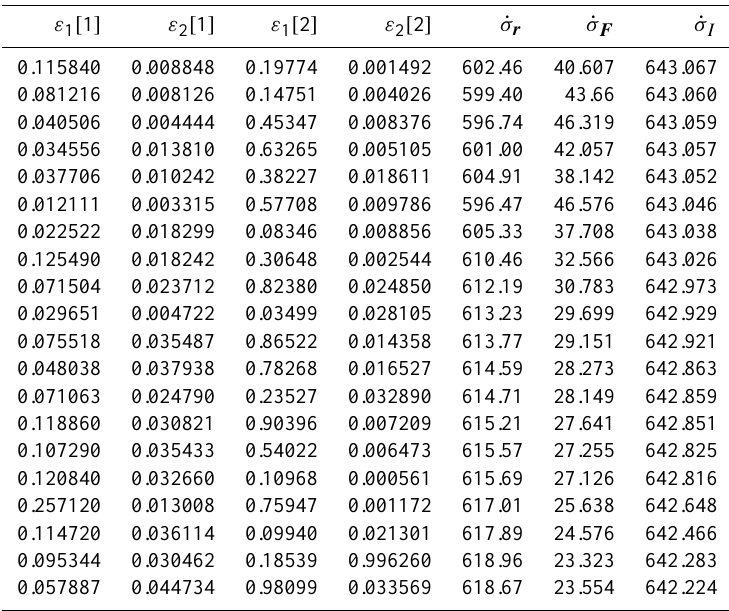
Table 3. Values in 4-D ε i [ j ]-space that correspond to the 20 highest internal entropy production rates, ˙ σ I Eq. (16), (J m − 2 d − 1 ◦ K − 1 ) from the 100000 Monte Carlo simulations. Here ˙ σ r = ˙ σ r total internal entropy productions from reactions and mixing, respectively.